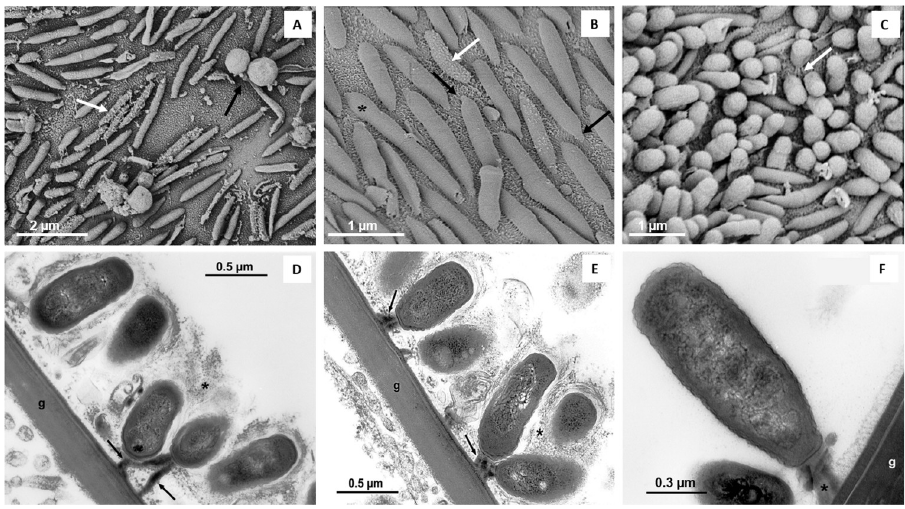
Fig 3. SEM images of bacteria associated with gills of Cranuca inversa ( A–C ) and TEM images of prokaryotes associated with gills of Parisesarma guttatum ( D–F ). Different morphologies are visible within the groups of prokaryotes on the gill surface: Rough (white arrow) and smooth horizontal rod-shaped, and cocci (black arrow) ( A ). Smooth and rough (white arrow) spindle-like prokaryotes with visible distal peduncles (black arrows) lying horizontally on the gill chitinous cuticle ( B ). Dividing prokaryotic cells ( � ). Prokaryotes perpendicularly attached to the gill cuticle ( C ). Filaments showing cell-gill attachment are visible (black arrow). Groups of prokaryotes near the gill (g) ( D ). Arrows = pili, arrowhead = large electron-dense filaments that extend from the terminal part of the prokaryotes towards the branchial cuticle. This image appears to indicate the mechanism of adhesion of the bacteria to the gills, while the pili are oriented on the opposite side of the gills. Groups of prokaryotes in contact with the gill (g) ( E ). The prokaryotes appear to be enveloped in a layer of amorphous material ( � ). Electron-dense filaments are evident, extending from the terminal part of the prokaryote towards the branchial cuticle (arrows). Detail of the large electron- dense filaments ( � ) which extend from the terminal part of the prokaryote towards the g, branchial cuticle (g) ( F ).